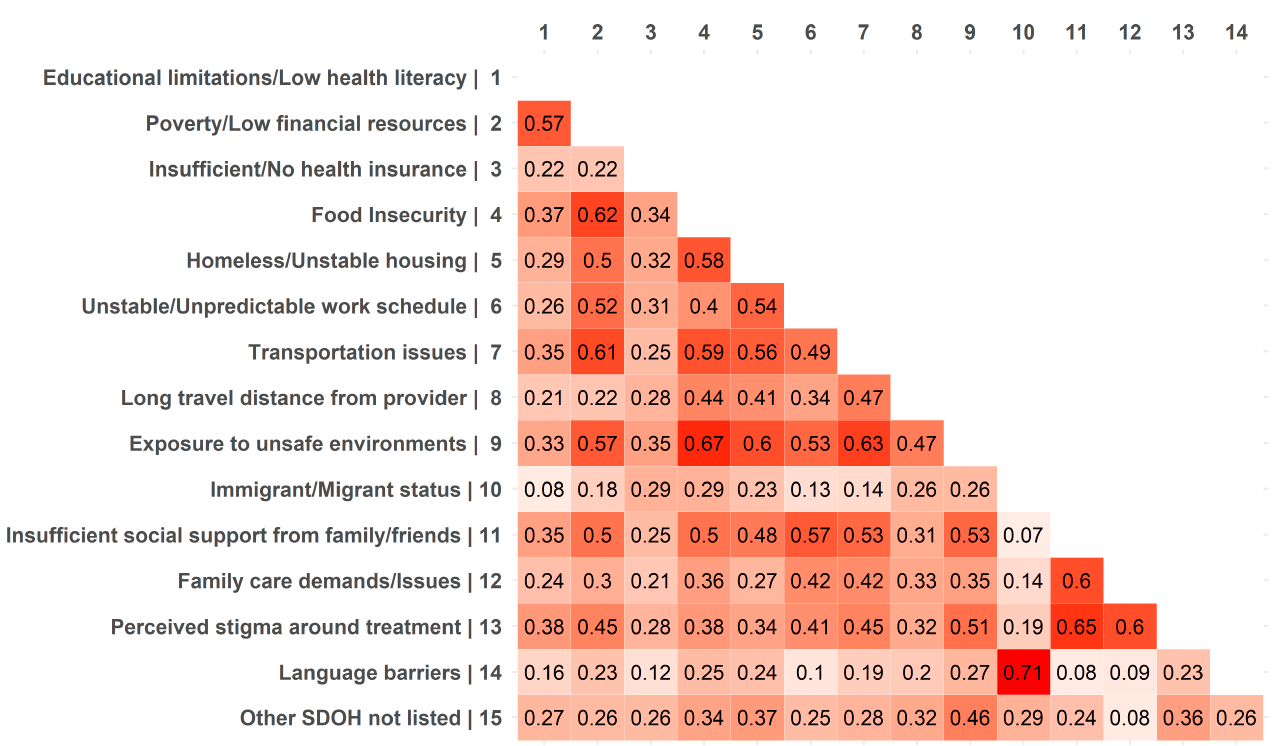
Figure 1. Heatmap of bivariate correlations for healthcare provider reports on portion of their patients experiencing each SDOH. Darker colors indicate stronger